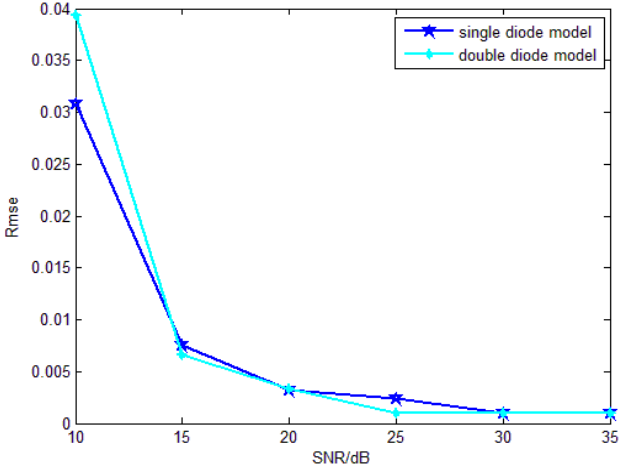
Figure 10. Robustness of the two different models against